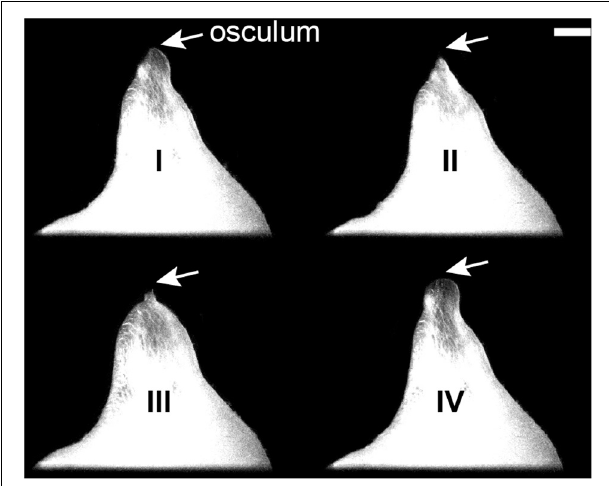
FIGURE 1 | Halichondria panicea , external morphology. Contractile phases of a single-osculum sponge explant ( ID #1); side-view projected area and osculum (arrows) are visible. I: Phase of contraction with osculum closure and reduction in projected area; II: contracted phase with closed osculum and minimum projected area; III: phase of expansion with opening of osculum and increase in projected area; IV: expanded phase with open osculum and maximum projected area. Scale bar: 1